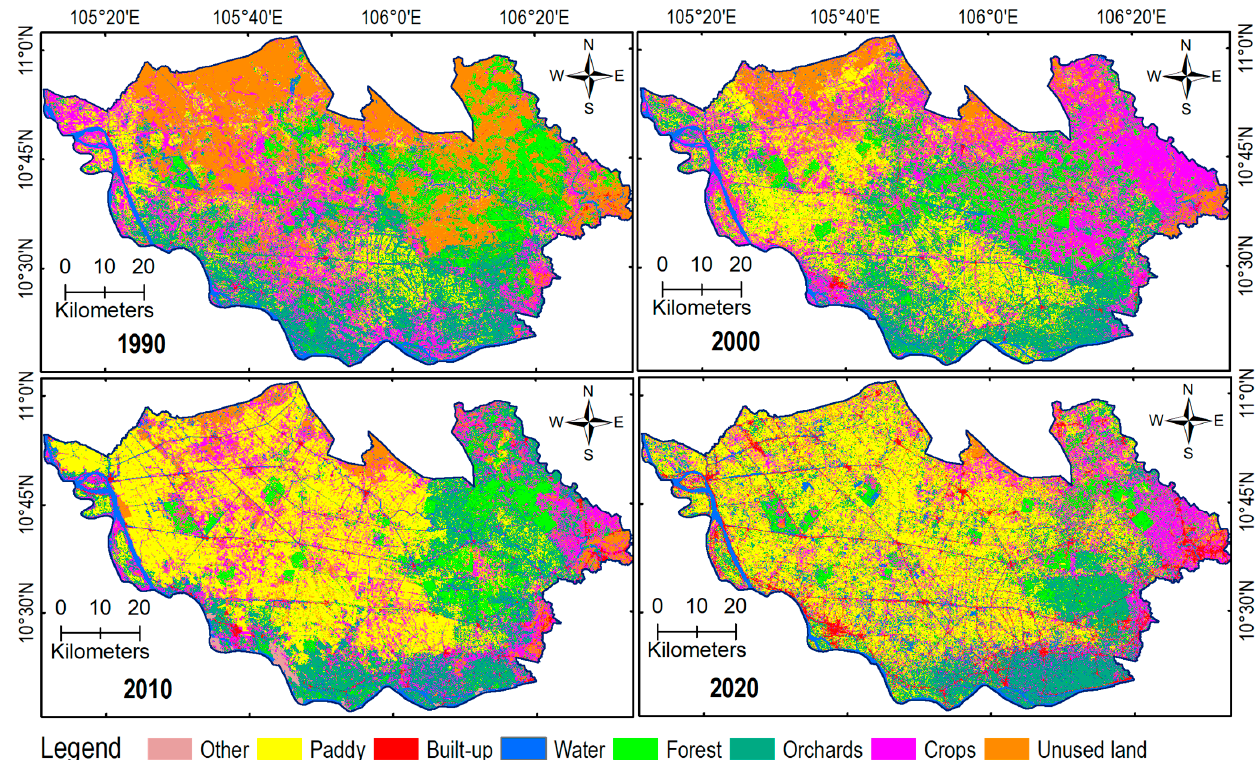
Figure 5. LULC classes in the Dong Thap Muoi area for the different years.